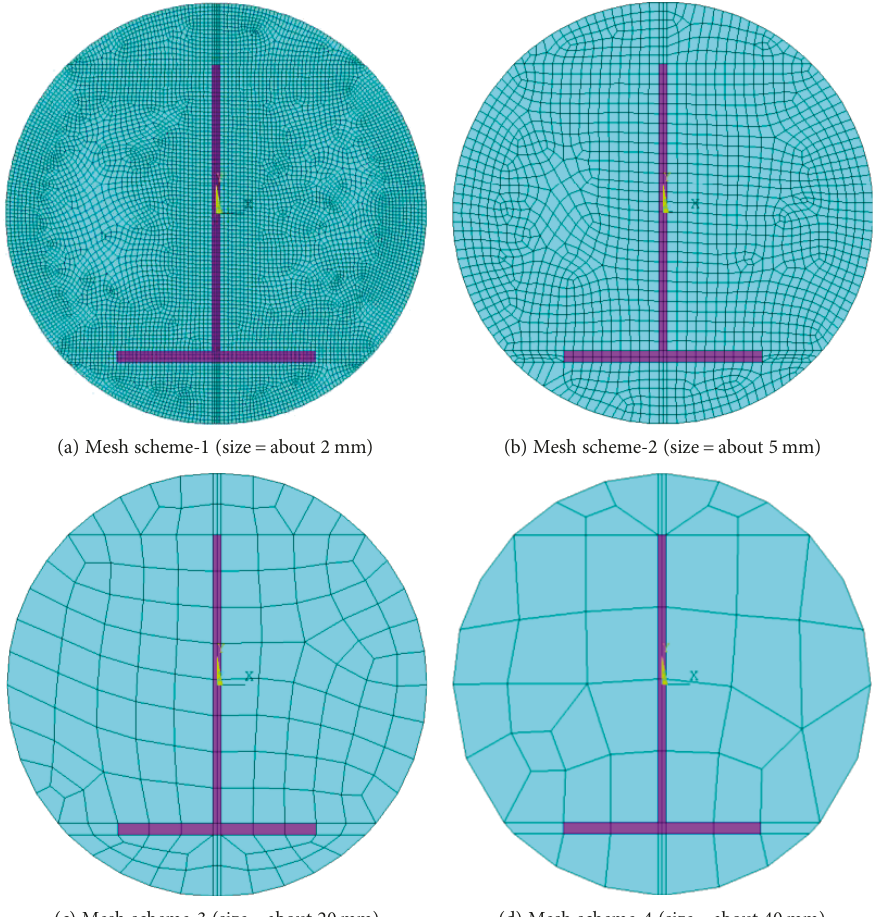
Figure 5: Mesh schemes for the prede fi ned column.